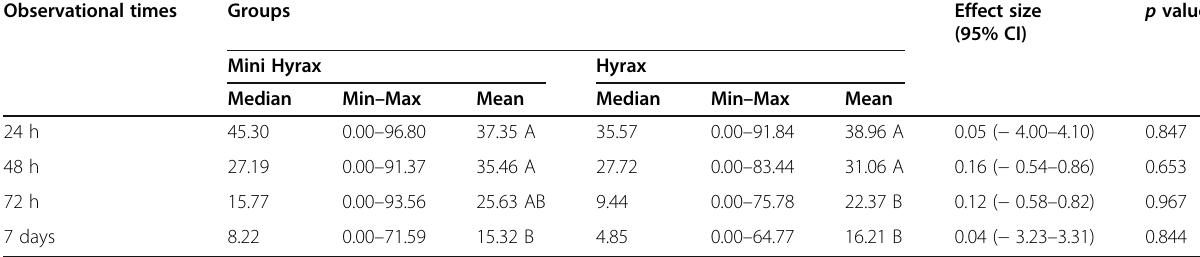
Table 5 Intragroup and intergroup comparison of the pain perception using the visual analogical scale (VAS) Observational times